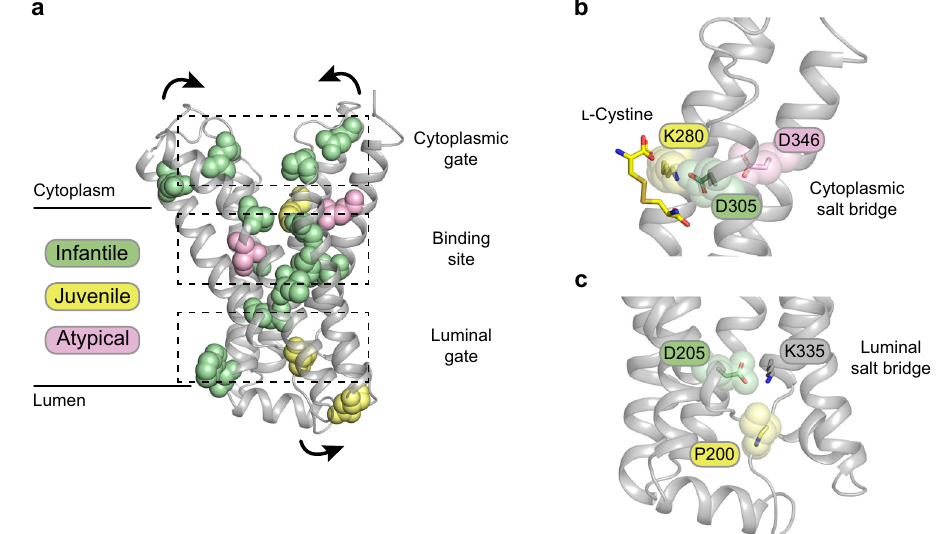
movementsthatoccurduringtransport. b Zoomedinviewofthecytoplasmicgate with the position of L -cystine superimposed. c Zoomed in view of the luminal gate with the inter bundle salt bridge residues